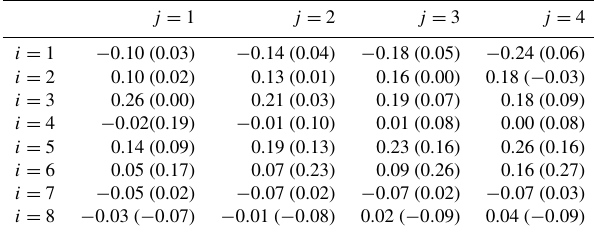
Table 2. The eight predictors used in the predictive model. Predictor Symbol